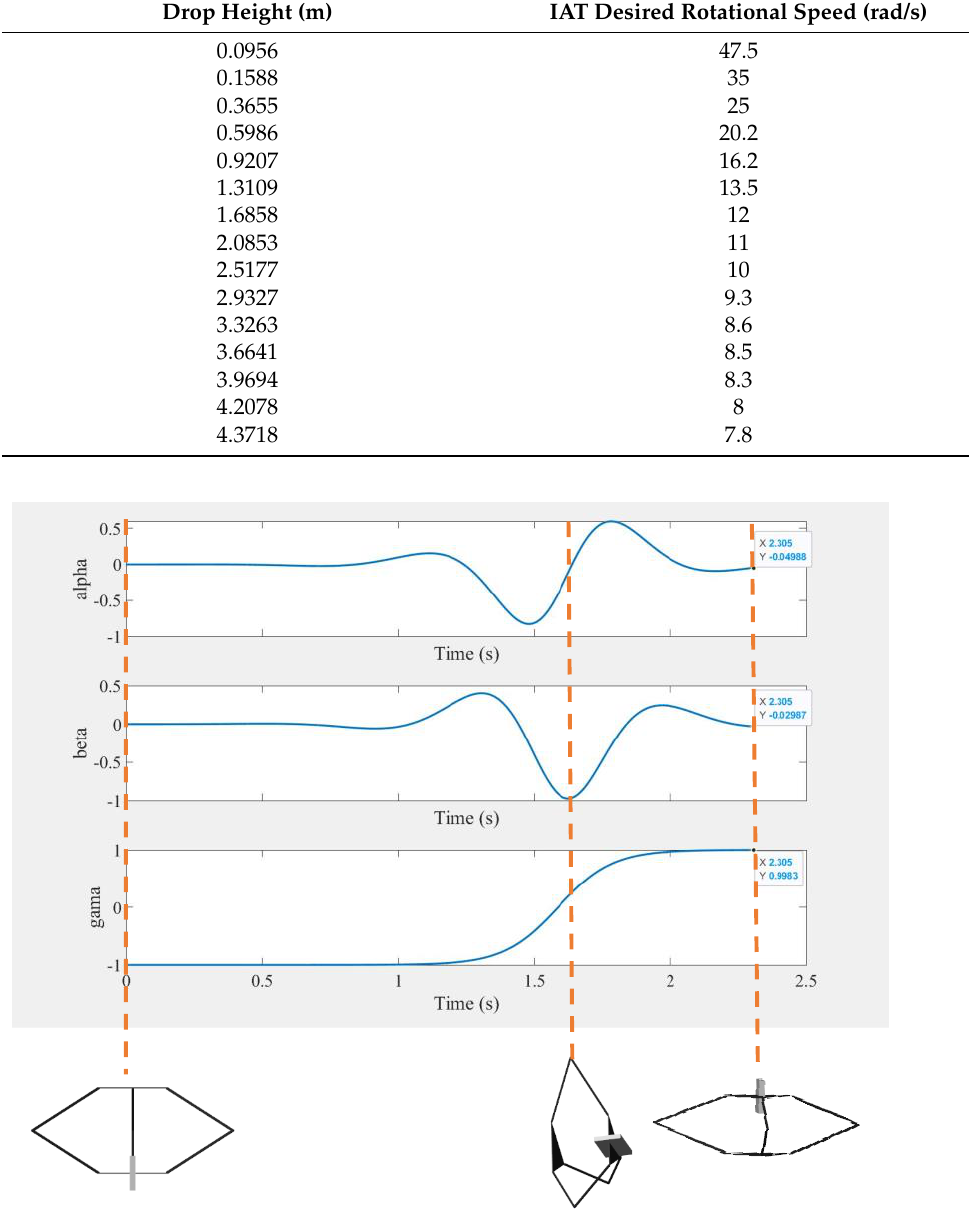
① ② ③ Figure 11. Direction cosine plot and three corresponding attitude diagrams of the model. As shown in Figure 12, the spiral path is the evolution of the attitude vector during falling. The attitude vector at the beginning of the simulation is ( − 0.0015, 0.0056, − 1), approximately (0, 0, − 1), which indicates that the robot’s attitude is vertically